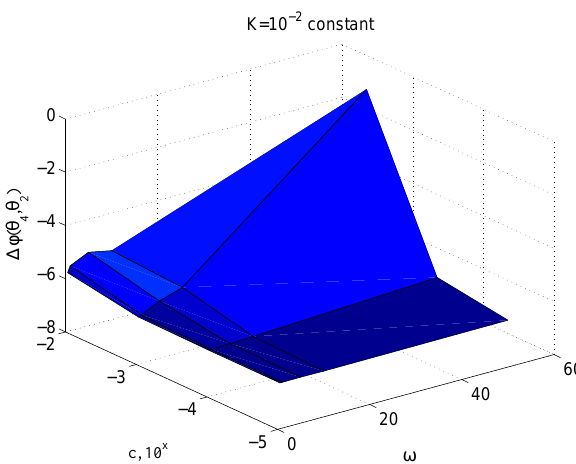
Figure 17. Dependency of the phase delay ∆ φ ( θ 4 , θ 2 ) with respect to c and ω for an assigned value of k .